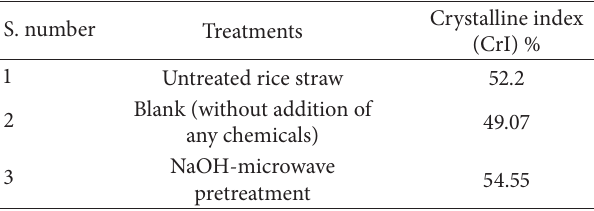
Table 6: Crystallinity index of rice straw